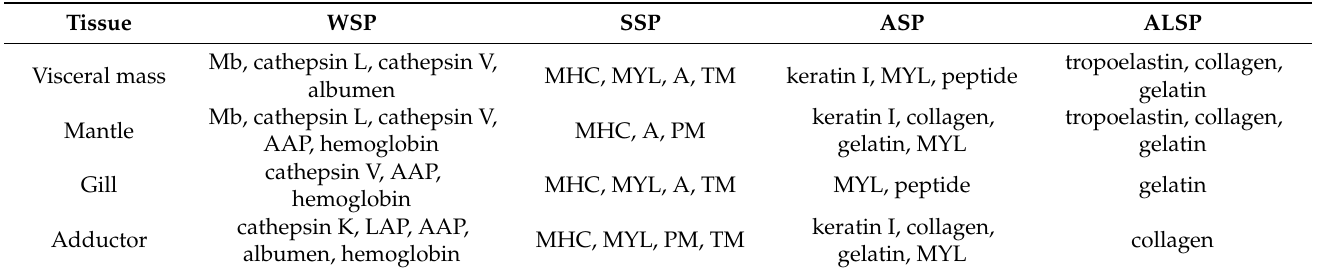
Table 2. Analysis of protein composition in different parts of oyster ( Crassostrea hongkongensis